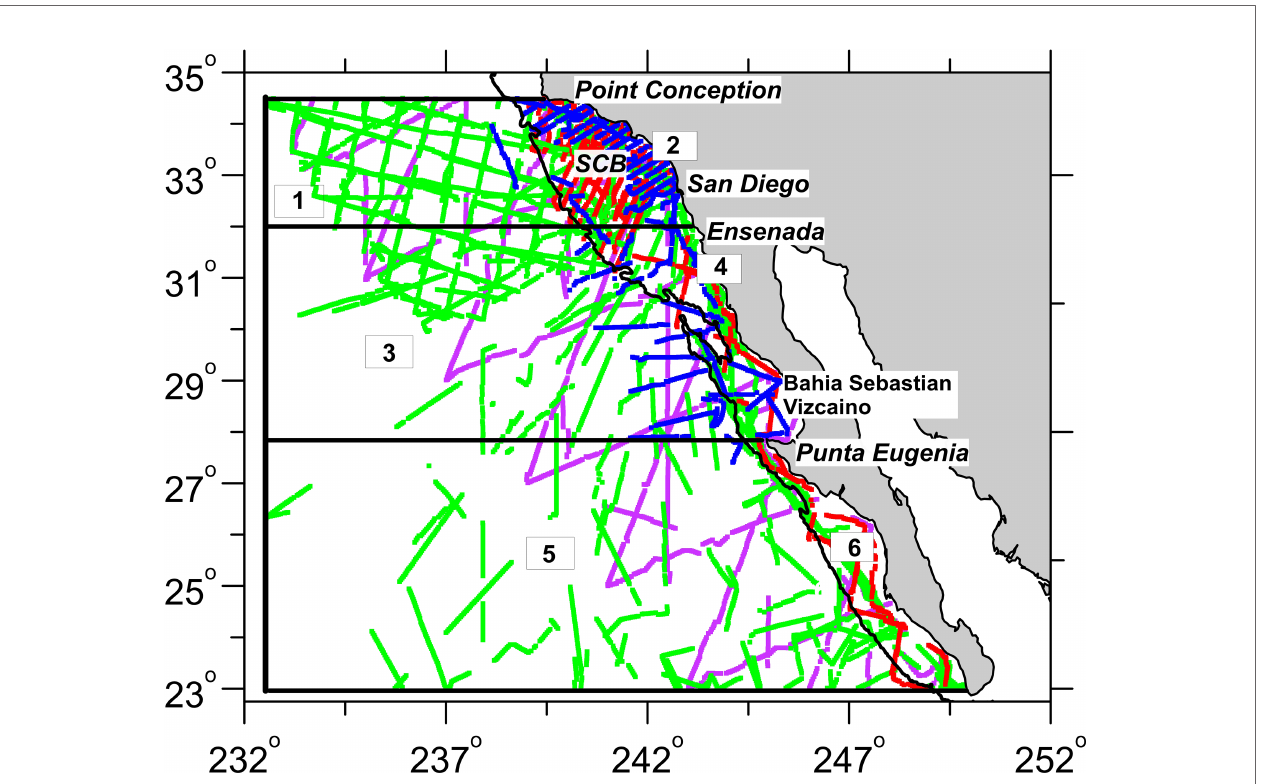
FIGURE 1 | Completed transects for the Southwest Fisheries Science Center systematic ship surveys conducted between 1992 and 2018 in the Southern California Current study area. The colored lines show on-effort transect coverage in Beaufort sea states ≤ 5: purple lines = 1993 survey, blue lines = 2009 survey, red lines = 2018 survey, green lines = transits in waters west of the Baja California peninsula and surveys that included U.S. waters within the Southern California Bight (SCB). Also shown are the six geographic strata used to evaluate the accuracy of the spatial patterns of predicted density, with the offshore/inshore division set at the 2,000 m isobath: (1) offshore north of the approximate location of the Ensenada Front in August (EF; 32°N), (2) inshore north of the EF, (3) offshore north of Punta Eugenia, (4) inshore north of Punta Eugenia, (5) offshore south of Punta Eugenia, and (6) inshore south of Punta Eugenia.